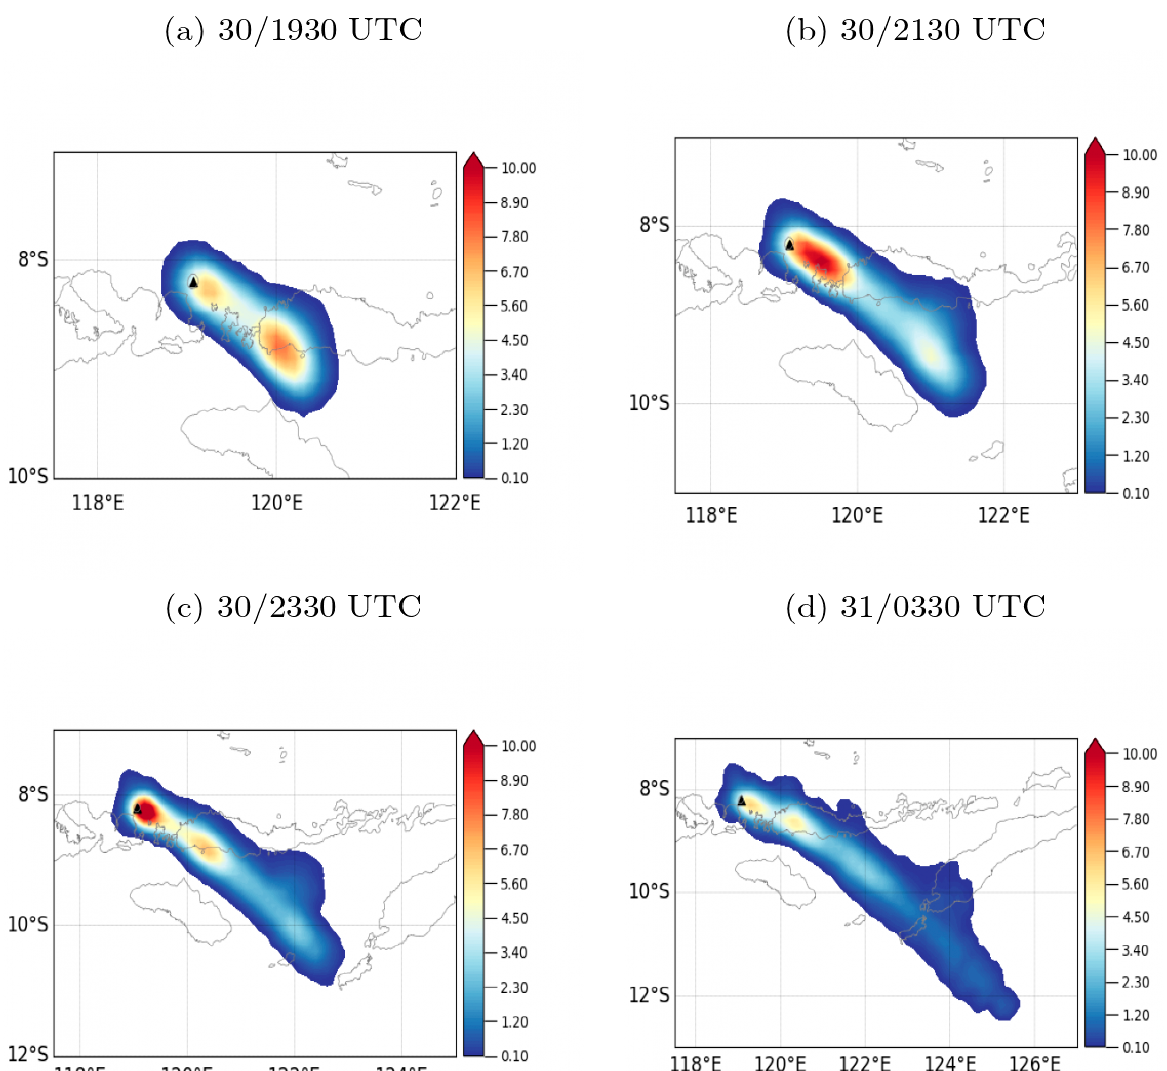
Figure 6. Ensemble mean mass load fields (in g/m 2 ) obtained from an experiment employing the time varying prior and posterior source height functions shown in Figure 1c,d. The black triangle indicates the volcano location.